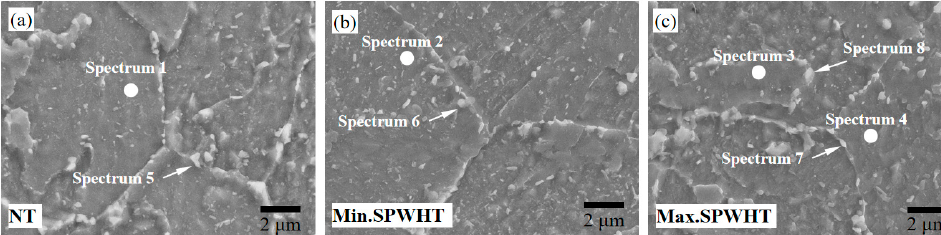
Figure 9. The position of the measured point in the ( a ) NT specimen, ( b ) Min.SPWHT specimen, and ( c ) Max.SPWHT specimen in the EDS test.